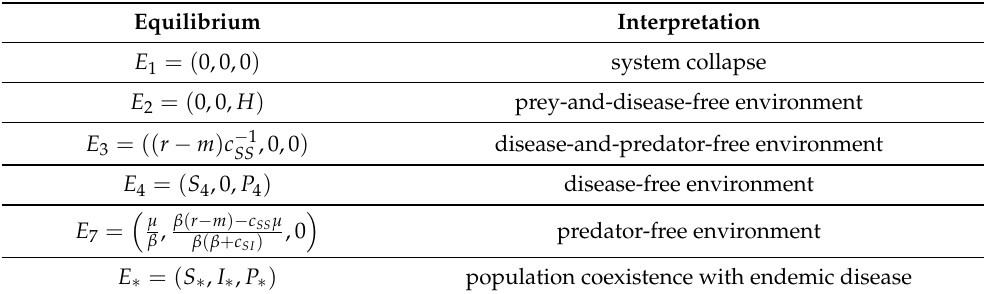
Table 1. Equilibria E k = ( S k , I k , P k ) of (1) and their ecological interpretation.